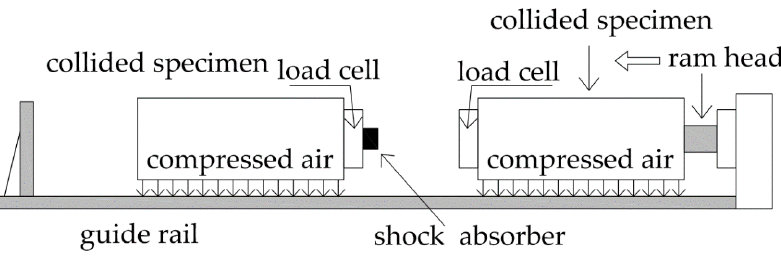
Figure 6. Experimental setup for impact between two steel frames [32].